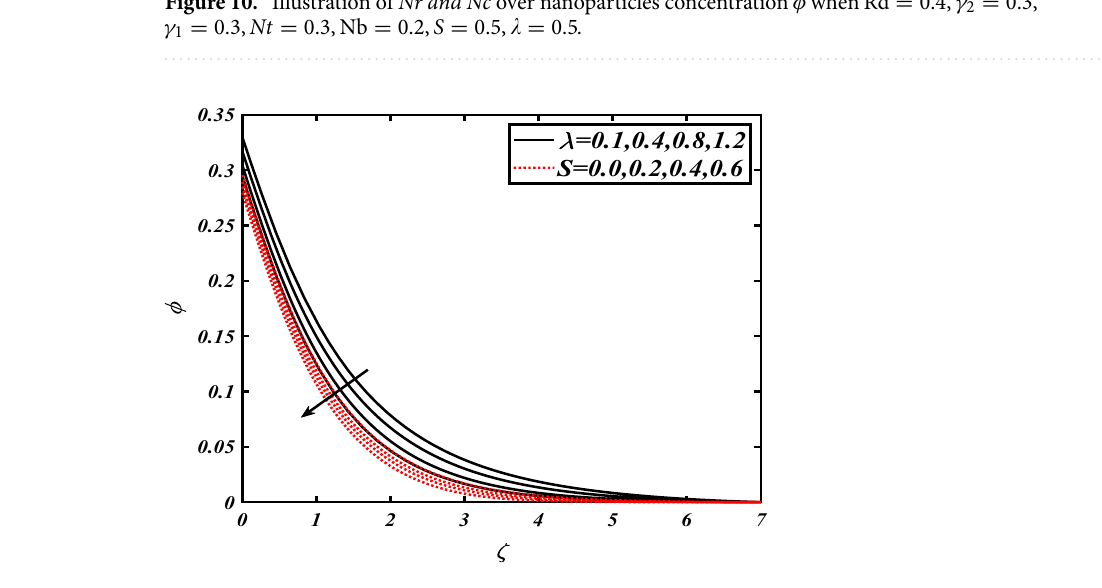
Figure 11. Illustration of (cid:31) and S over nanoparticles concentration φ when Rd = 0.4, γ 2 = 0.3, γ 1 = 0.3, Nt = 0.3, Nb = 0.2, Nr = 0.2